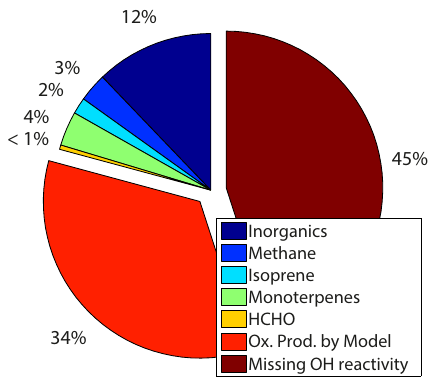
Figure 16. Simulated contributions to the observed total OH reac- tivity during